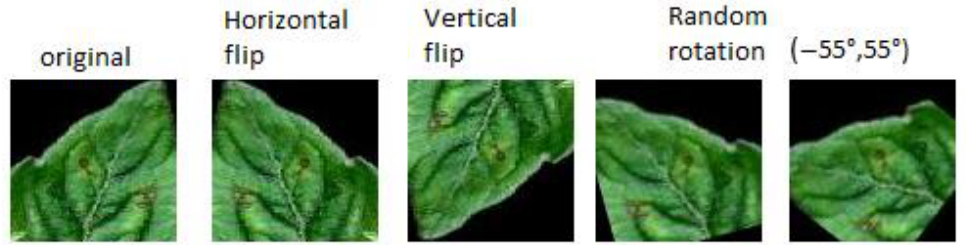
Figure 8. Example of data augmentation on the new training dataset.